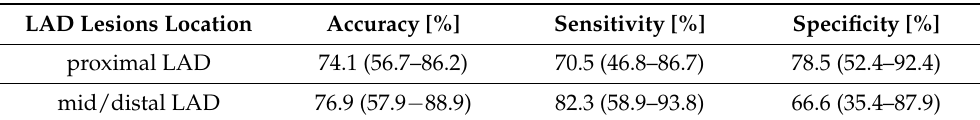
Table 8. Diagnostic performance and 95% CI of the model for different lesion locations on the LAD. LAD Lesions